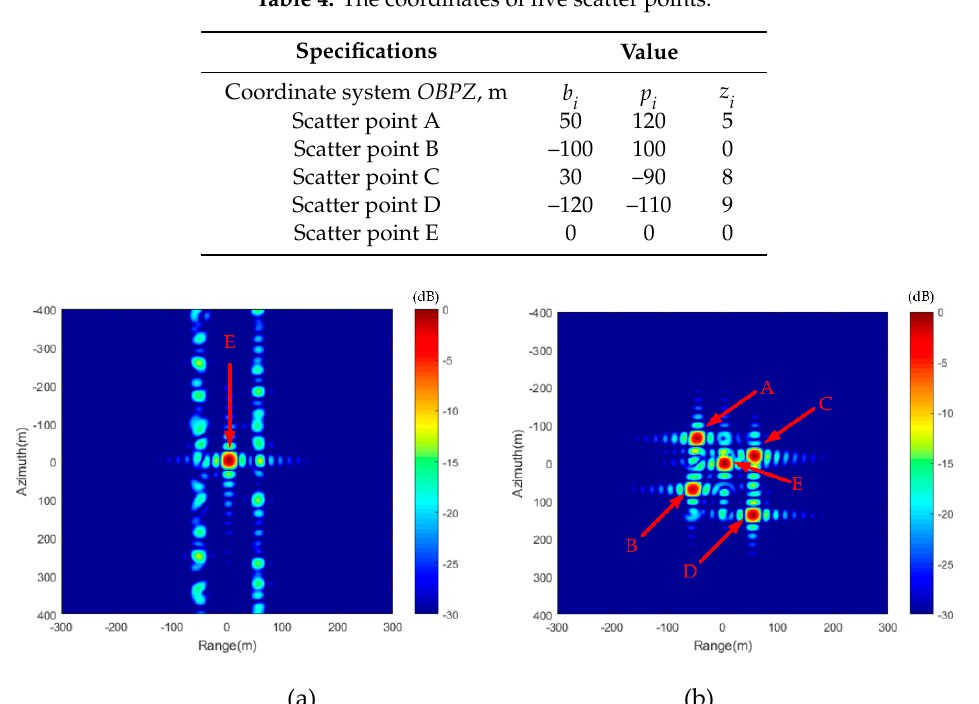
Table 4. The coordinates of five scatter points.